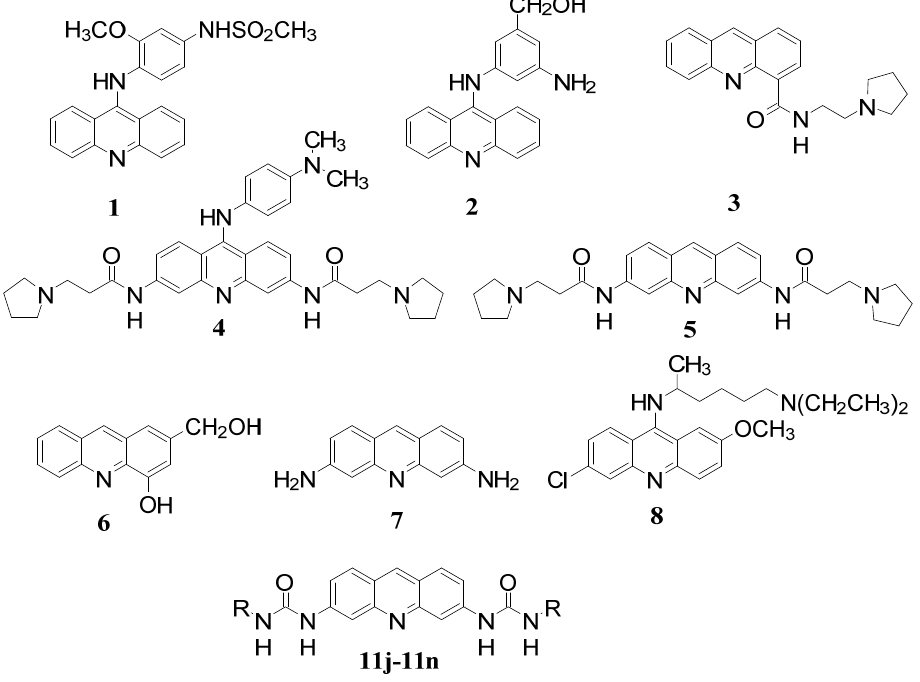
Figure 1. Acridine derivatives with biological activity.